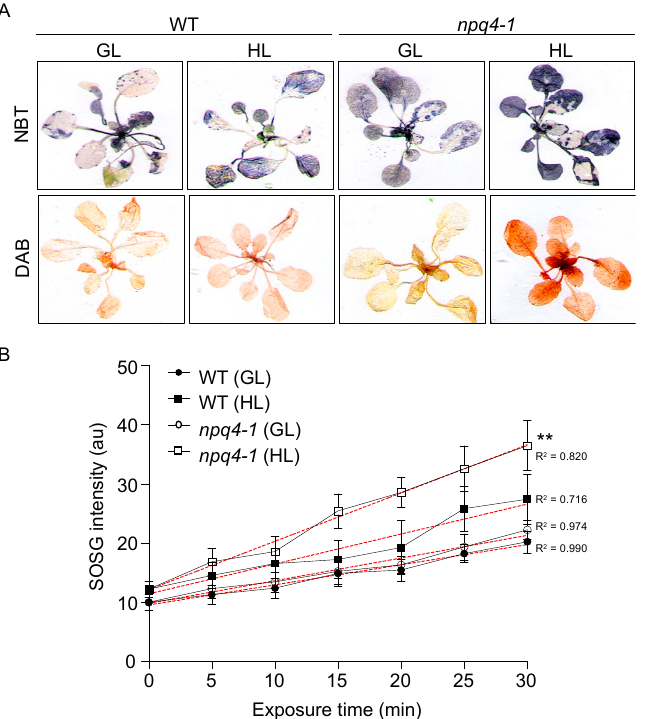
Figure 6. ROS production in wild-type and npq4-1 mutants under growth light and high light illumination. ( A ) Production of superoxide anion radicals and hydrogen peroxide was detected by histochemical staining with NBT (top panel) and DAB (bottom panel) in wild-type (WT) and npq4-1 leaves, respectively. Leaves infiltrated with 6 mM NBT or 5 mM DAB solution by immersion for 12 h in darkness were treated with growth light (GL) at 70 μ mol photons m − 2 s − 1 or high light (HL) at 700 μ mol photons m − 2 s − 1 for 2 h. The leaves were decolorized by immersing them in 70% ethanol. Experiments were repeated 4–6 times and representative images are shown; ( B ) Detection of singlet oxygen in leaves, as monitored by the increase in SOSG fluorescence emission at 530 nm. Leaf seg- ments were vacuum infiltrated with 200 μ M SOSG solution before being illuminated for 30 min with GL at 70 μ mol photons m − 2 s − 1 or with HL at 700 μ mol photons m − 2 s − 1 . Regression line plotted as red dashed line estimated via nonlinear least square regression. R 2 denotes the regression coeffi- cient. Significance differences of fitted curves are indicated by asterisks (** p < 0.01) compared to the 0 h as determined by one-way ANOVA with Fisher’s LSD test.